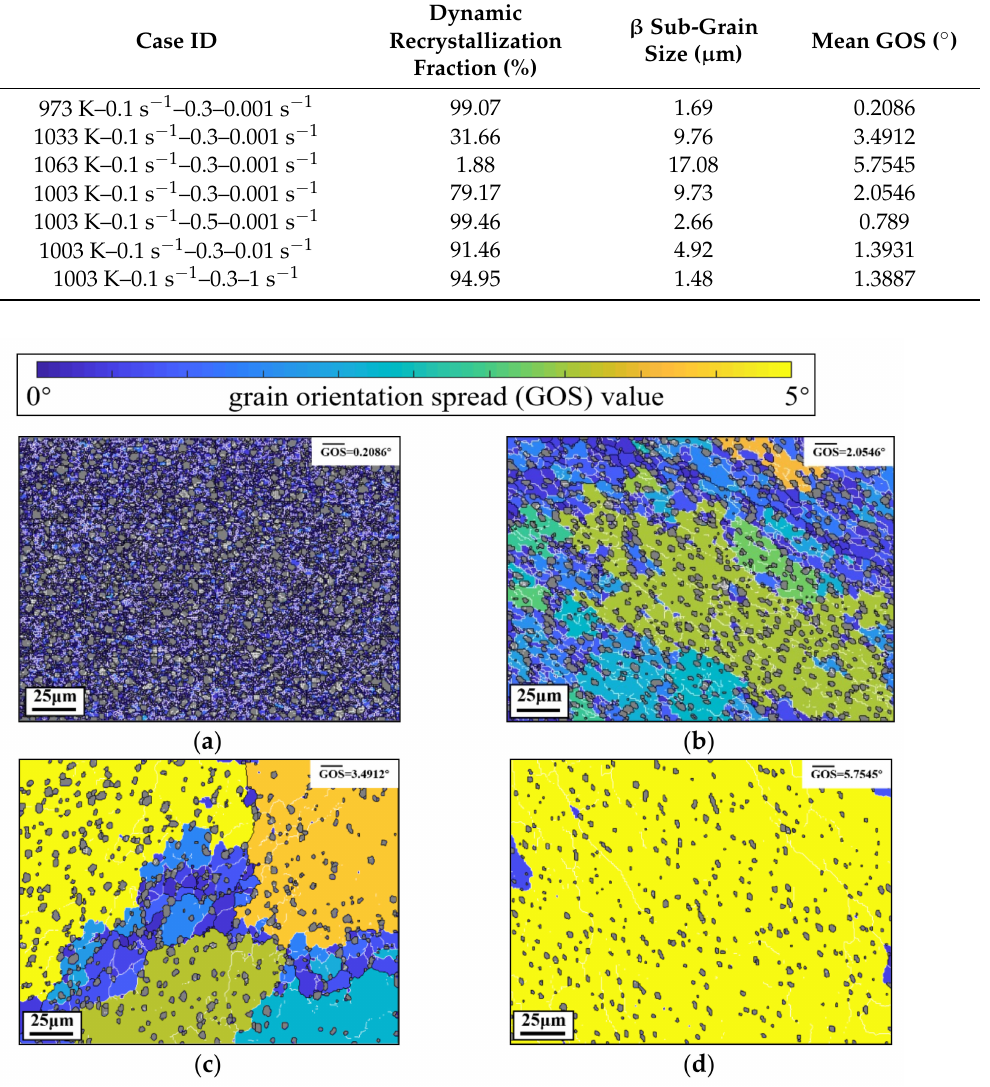
Figure 5. GOS maps of the Ti-55511 alloy compressed at different